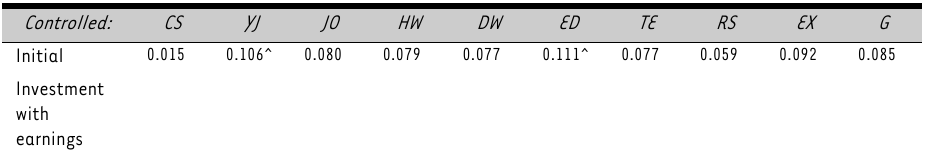
Partial correlations between initial investment and continuance satisfaction with variables controlled